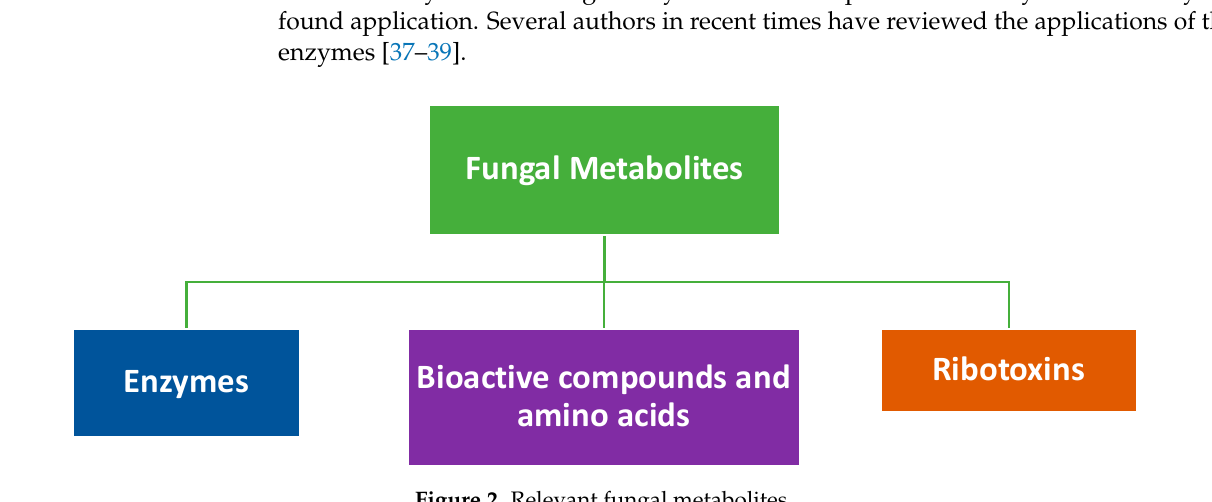
Figure 2. Relevant fungal metabolites.